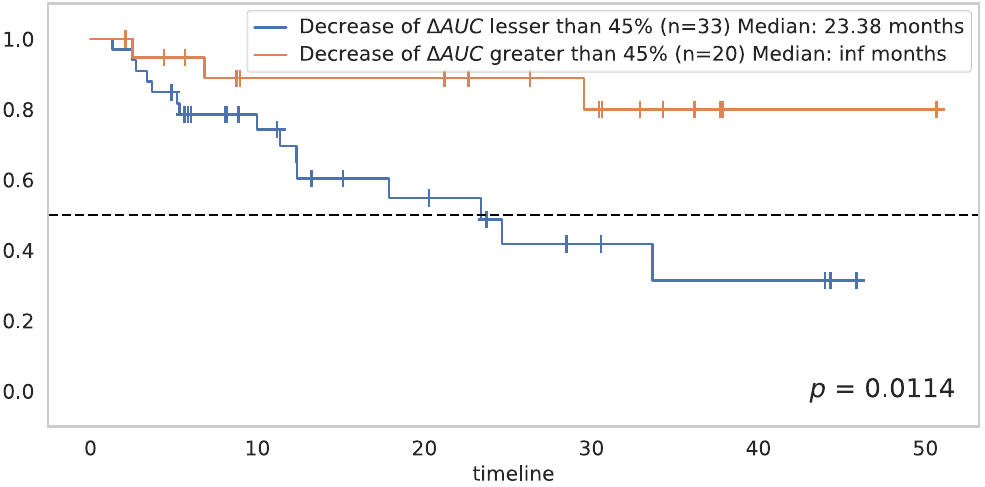
Figure 5. Impact on overall survival of a decrease in AUC from baseline to D21 greater than 45%.